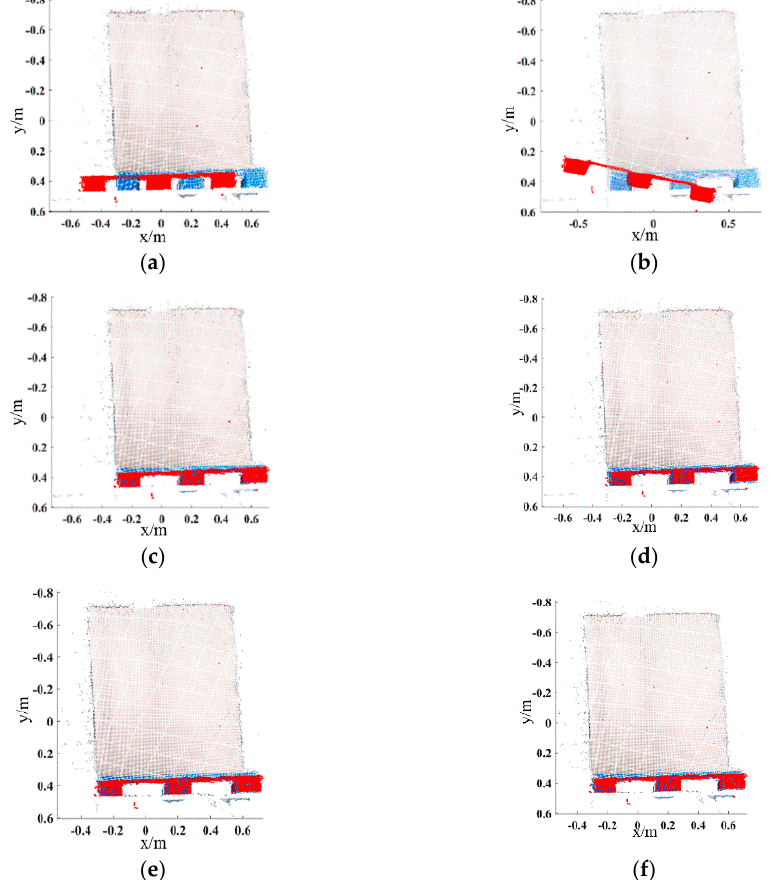
Figure 18. Point registration results based on different methods in the ground scene. ( a ) Initial position. ( b ) Traditional ICP. ( c ) The method based on SHOT + ICP. ( d ) The method based on FPFH + ICP. ( e ) The method based on CFPFH + ICP. ( f ) The proposed method. Table 4. RMSE and elapsed time comparison of different feature descriptors.